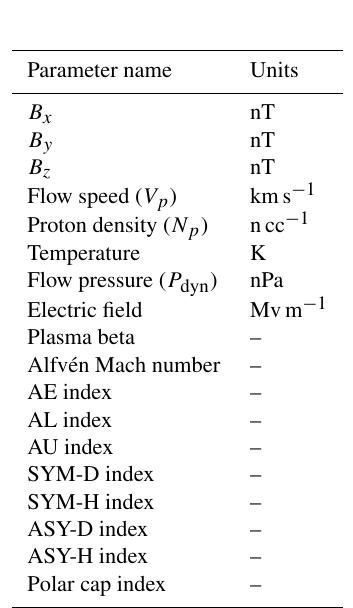
Figure 2. The schematic of extracting auroral boundary points. Table 1. Space physical parameters selected from the OMNI